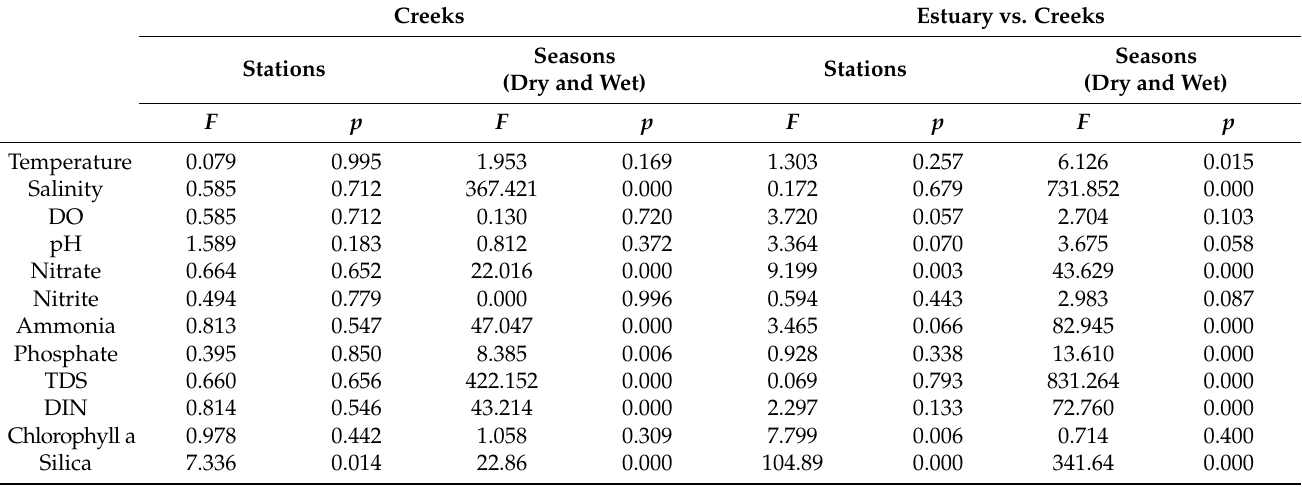
Table 1. Two-way analysis of variance for differences of ecologically important parameters on sampling stations and sampling months for the survey in the tidal mangrove creeks of the PRE. F indicates the likelihood ratio; p indicates the